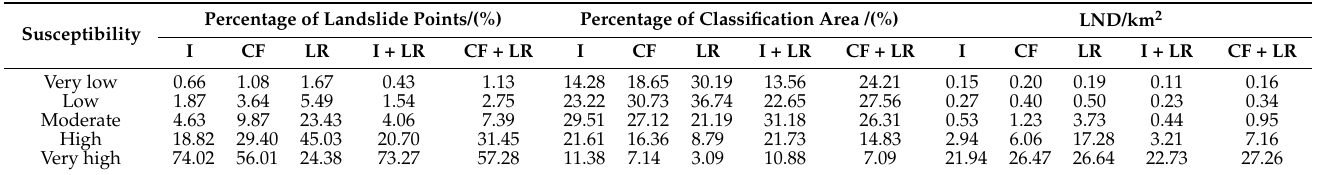
Table 3. Statistics of Jiuzhaigou landslide susceptibility.